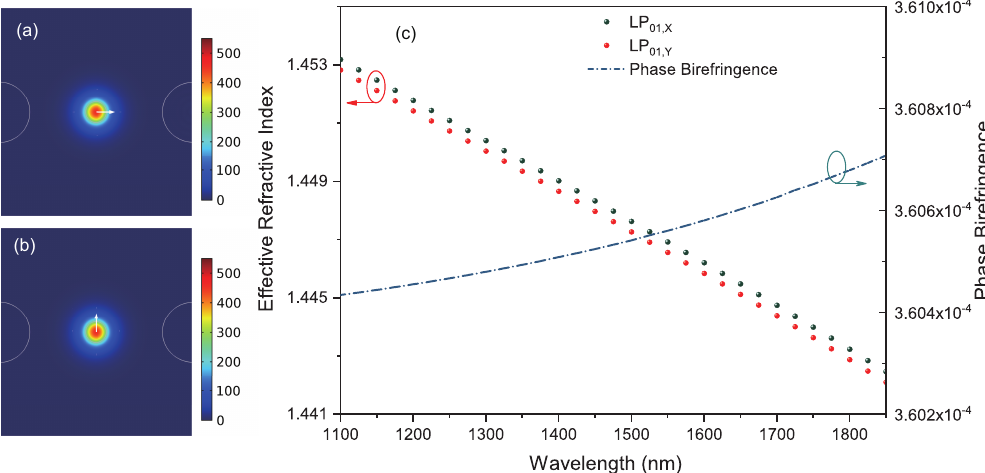
Figure 5. The electric field distribution of x-polarized fundamental mode ( a ) and y-polarized fundamental mode ( b ). ( c ) The effective refractive index variations of x-polarized (black sphere) and y-polarized (red sphere) modes in the wavelength range from 1100 nm to 1900 nm, and the dispersion curve of the corresponding phase birefringence (dark blue dot-dash